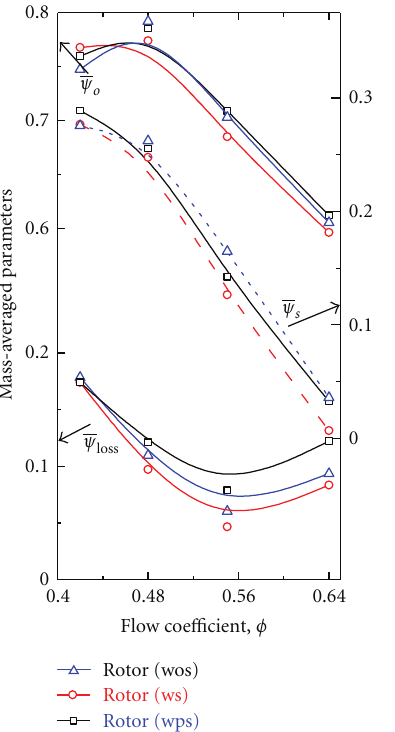
Figure 8: Mass-averaged performance of the Low-Aspect-Ratio Axial-Flow Fan Rotor.